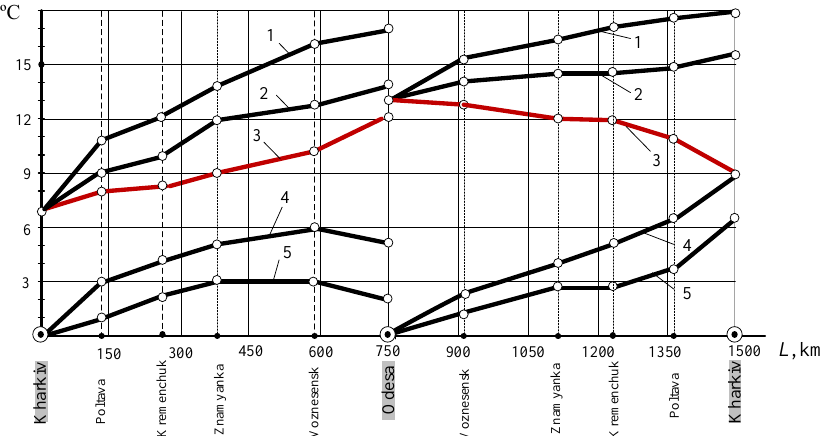
Figure 5. Graphs of generalized temperature functions T °C depending on the distance L of the passenger car of the Kharkiv-Odesa and Odesa-Kharkiv trains in forward and reverse directions, obtained during a month of research (curve 1 — for the typical design of a cylindrical roller bearing; 2 — for the modernized design; 3 — environment (air); 4 — the temperature gradient of the typical design and the environment; 5 — the temperature gradient of the modernized design and the environment.